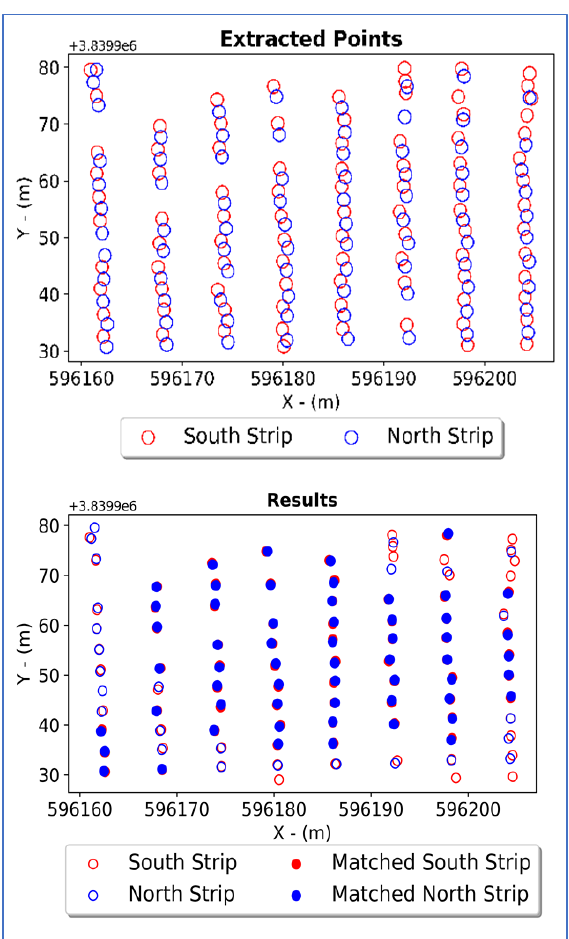
Figure 7. Test Plot I Results (top row: the extracted keypoints), (bottom row: the alignment results of the keypoints) The alignment accuracy has been evaluated by comparing the planimetric differences between the matched points before and after adjustment for the two test plots. The validation criteria demonstrate an improvement of the planimetric deviation range from 1.33 m to 2.27 m before alignment to 0.03 m to 0.5 m after alignment for the test plot one (top row in figure 9). The same values were investigated for the test plot 2 (figure 9 bottom row). The range before alignment was from 1.27m to 3.1m while after